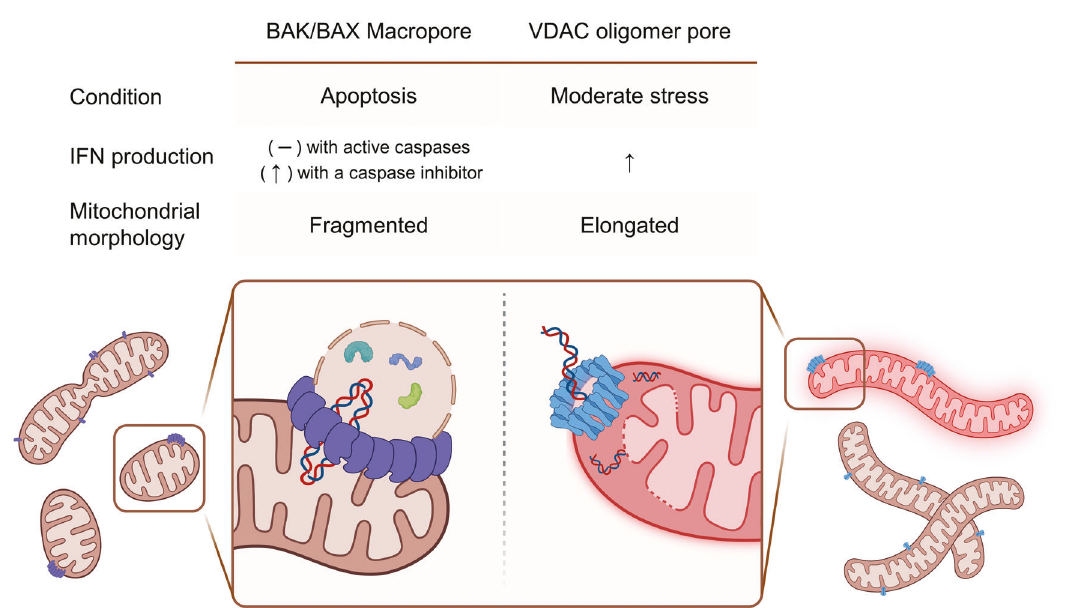
Fig. 6 mtDNA release via permeabilization of the mitochondrial outer membrane. (Left) During BAK/BAX-mediated apoptosis, mitochondria undergo hyperfragmentation, and mitochondrial matrix components, including mtDNA, are released into the cytosol through BAK/BAX macropores. mPTP opening is not required for MIM disruption. The released mtDNA does not activate the type-I IFN pathway because of caspase activation. (Right) Mitochondrial stress triggers the formation of VDAC-oligomer pores and activates the type-I IFN pathway. mPTP opening is required for MIM disruption.